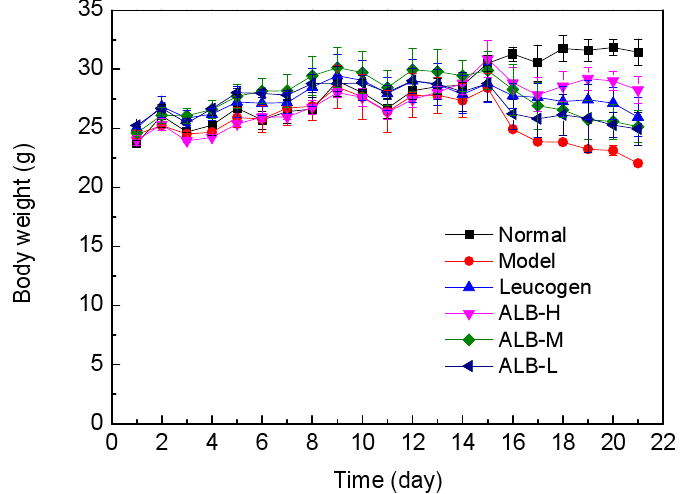
Figure 1. The changes of body weight of mice caused by irradiation. The ALB-H/M/L groups were given ALB daily by intragastric administration based on dose of 200, 100, and 50 mg/kg body weight (b.w.) per day for 14 consecutive days. All mice, except the Normal control group, were exposed to 6.0 Gy 60 Co γ -ray whole-body radiation on day